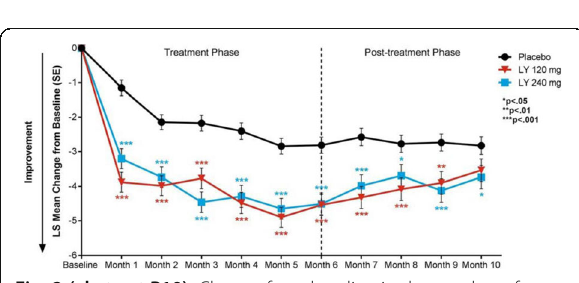
Fig. 2 (abstract P19). Change from baseline in the number of monthly migraine headache days during 6 months treatment and 4 month post-treatment period for